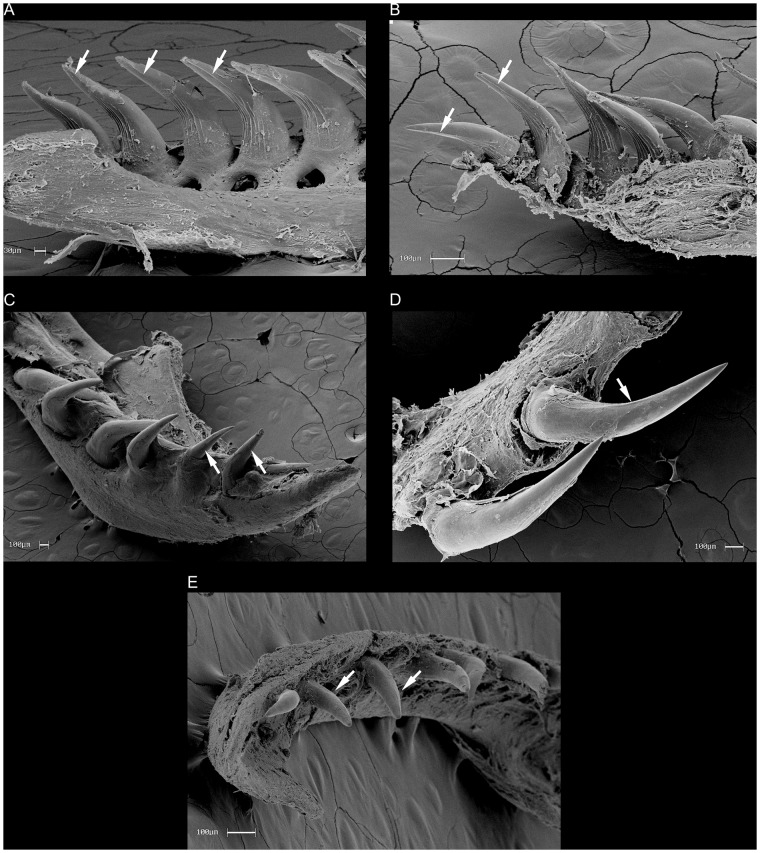
Scanning electron microscopy of maxillary teeth in Acrochordidae,
Xenodermidae, Pareidae, and Xylophiinae.(A) right posterior maxillary teeth of Achalinus
formosanus in lingual view; (B) right posterior
maxillary teeth of Achalinus rufescens in lingual
view; (C) right posterior maxillary teeth of Acrochordus
granulosus in labial view; (D) left posterior maxillary
teeth of Pareas sp. in lingual view; (E) right
posterior maxillary teeth of Xylophis perroteti in
labial view. White arrows are pointing to the lateral (labial) and
medial (lingual) ridges in the posterior maxillary teeth.